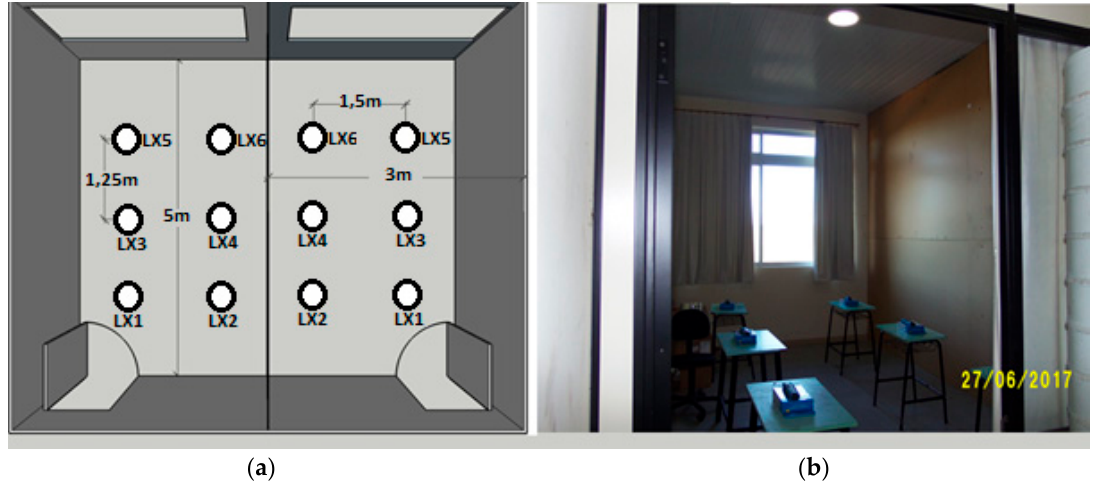
Table 4. Table of the average hour of the validation days (Reference vs. Prototype).